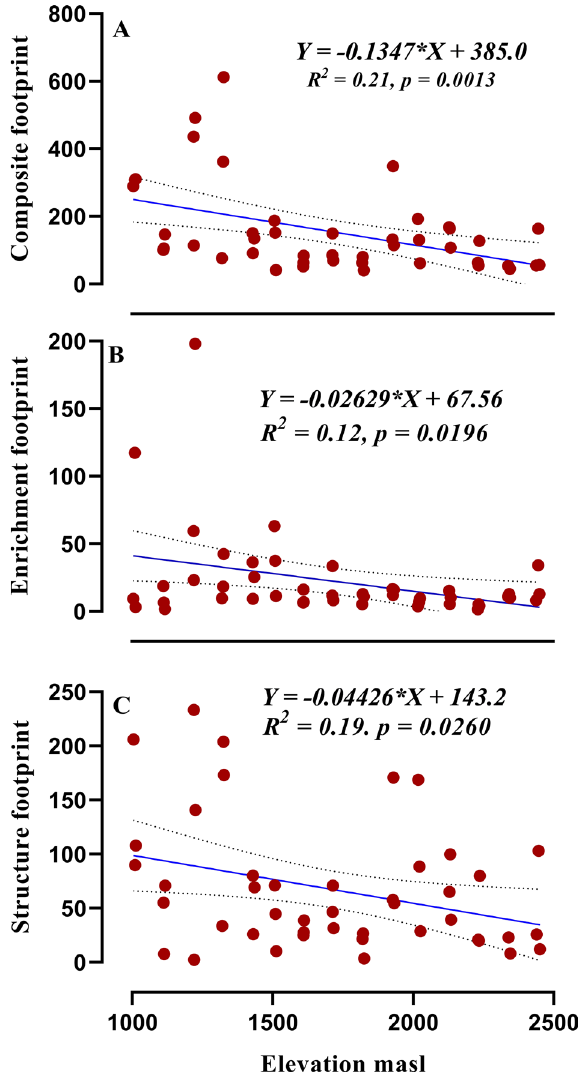
regression line are